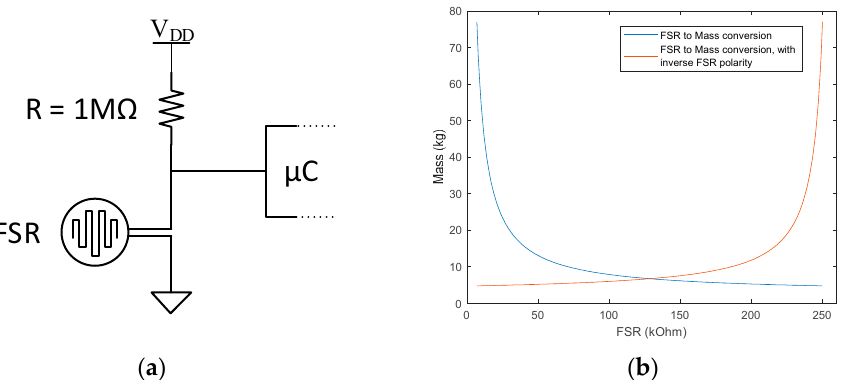
Figure 4. Deployment of the resistive pressure sensors for operation as force sense resistors: ( a ) schematics, ( b ) mass vs. resistance conversion characteristics.